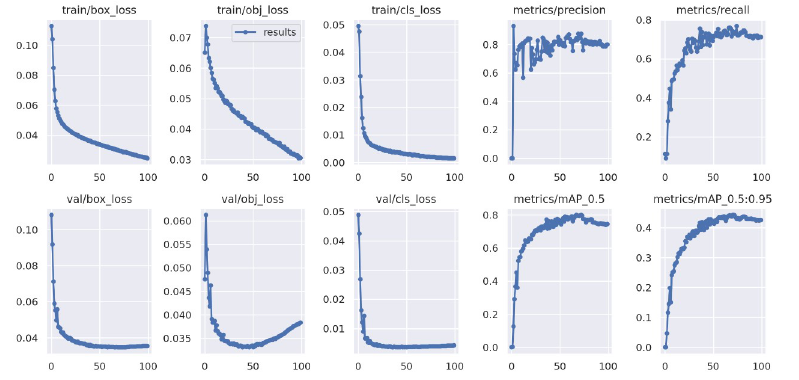
Figure 14. Performance values for improved YOLOv5 model.